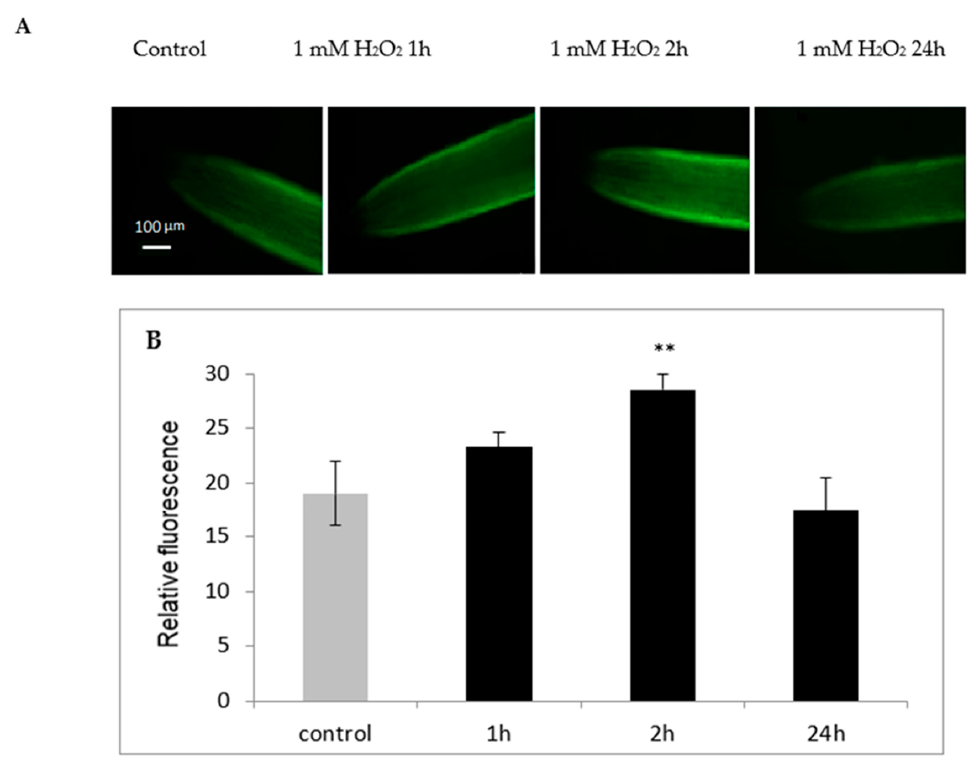
Figure 7. Bio-imaging of NO level in the roots of cucumber seedlings treated with H 2 O 2 for 1, 2, and 24 h ( A ) and the mean related fluorescence density ± SD ( B ). Control plants were not treated with H 2 O 2 . NO production was monitored by labeling with the NO-specific fluorescent dye DAF-2D and imaged using fluorescent microscopy. The images are representative for at least three roots for each treatment from four independent replications of the experiment. Asterisks on the figure indicate significant differences ( p < 0.01).